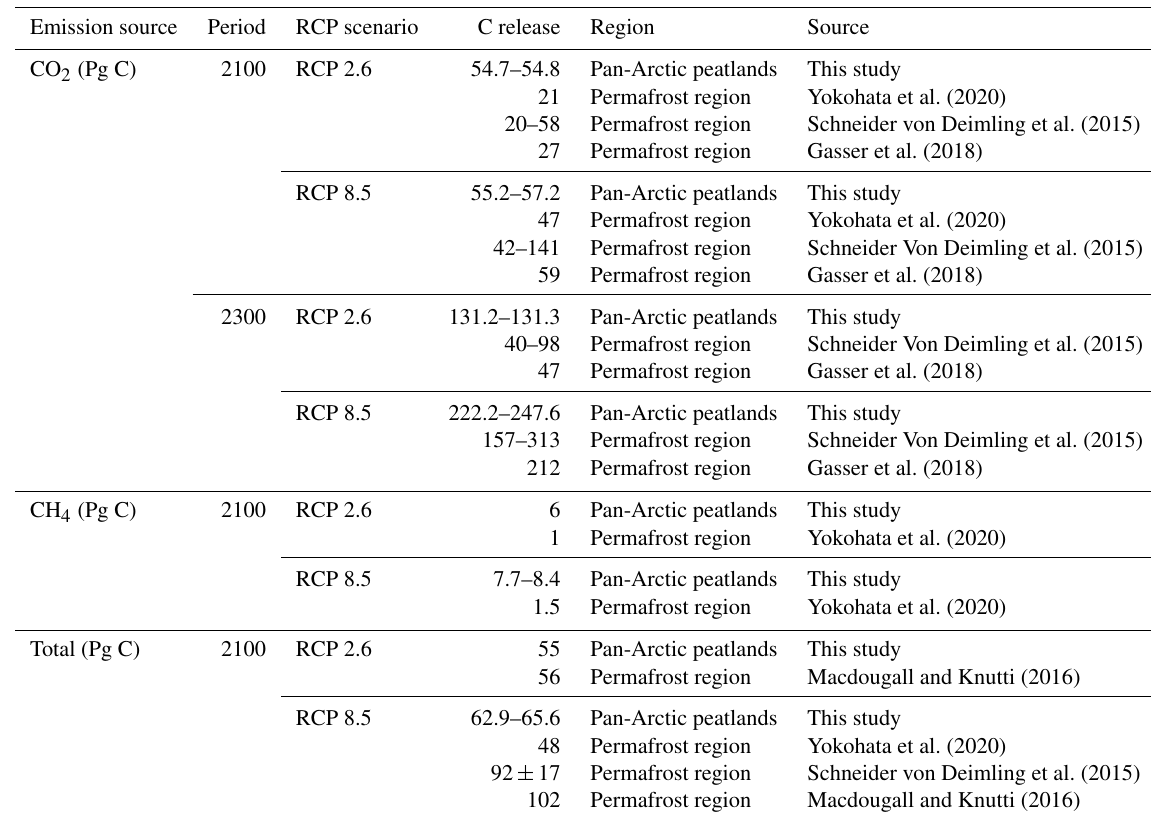
Table 5. Comparison of cumulative C emissions between this study and literature. Emission